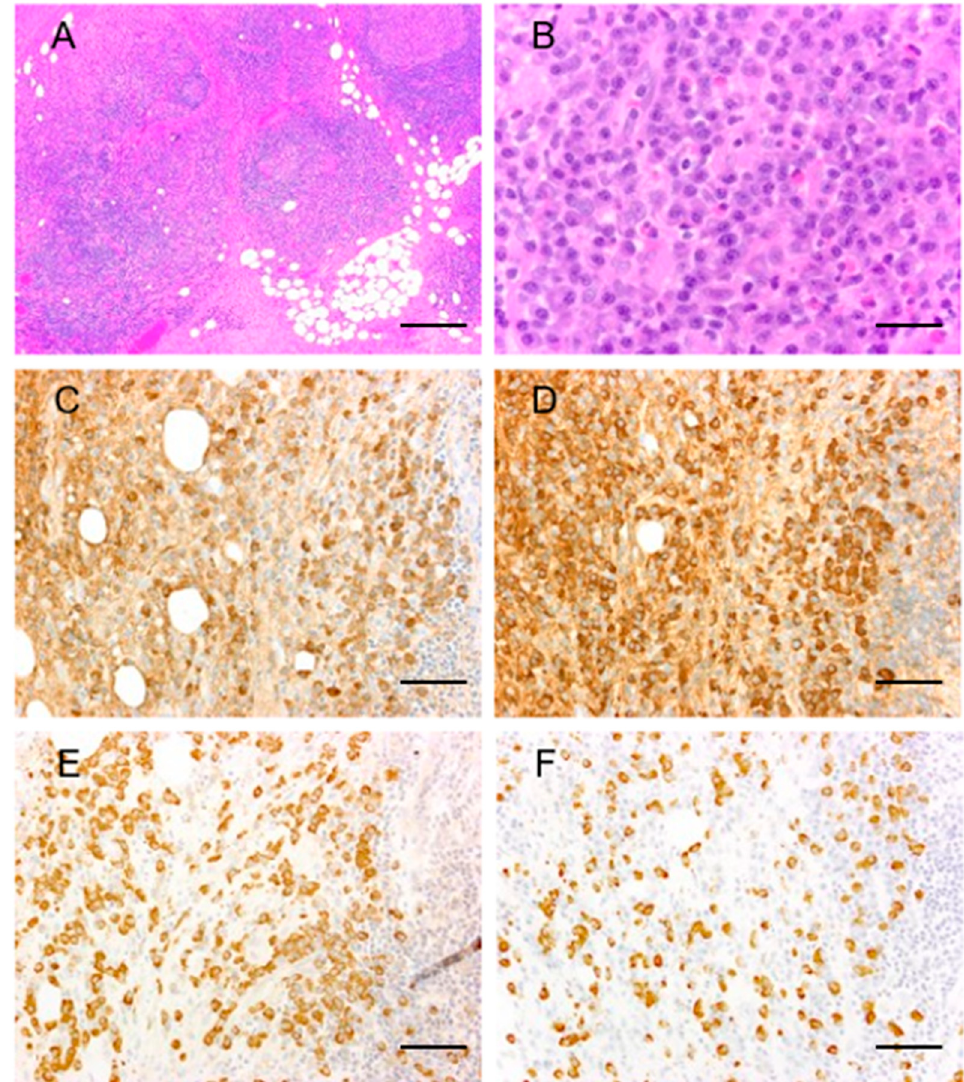
Figure 1. IgG4-related ophthalmic disease. Representative pathological images of IgG4-related ophthalmic disease. Marked lymphoplasmacytic infiltration with mild fibrosis, scattered eosinophils, and interspersed reactive lymphoid follicles ( A , B ) (hematoxylin and eosin). Numerous IgG+ ( C ) and IgG4+ ( D ) cells with an IgG4+/IgG+ cell ratio >40%. There were no light chain restrictions; Ig κ -ISH ( E ) and Ig λ -ISH ( F ). Scale bar; ( A ): 200 µm, ( B ): 50 µm, ( C – F ): 100 µm.